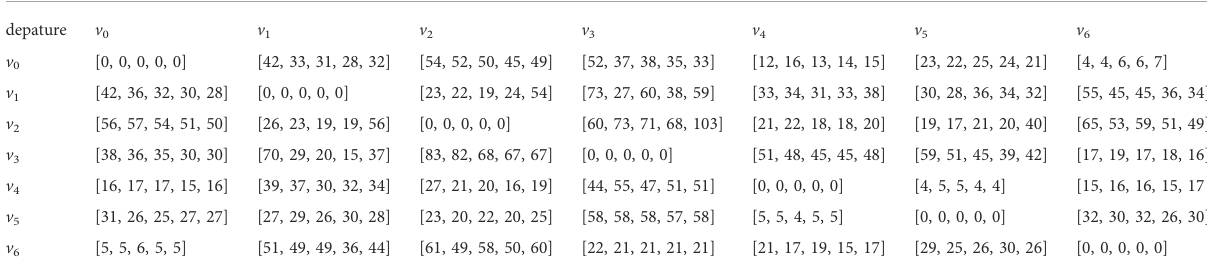
TABLE 2 Time weights W .